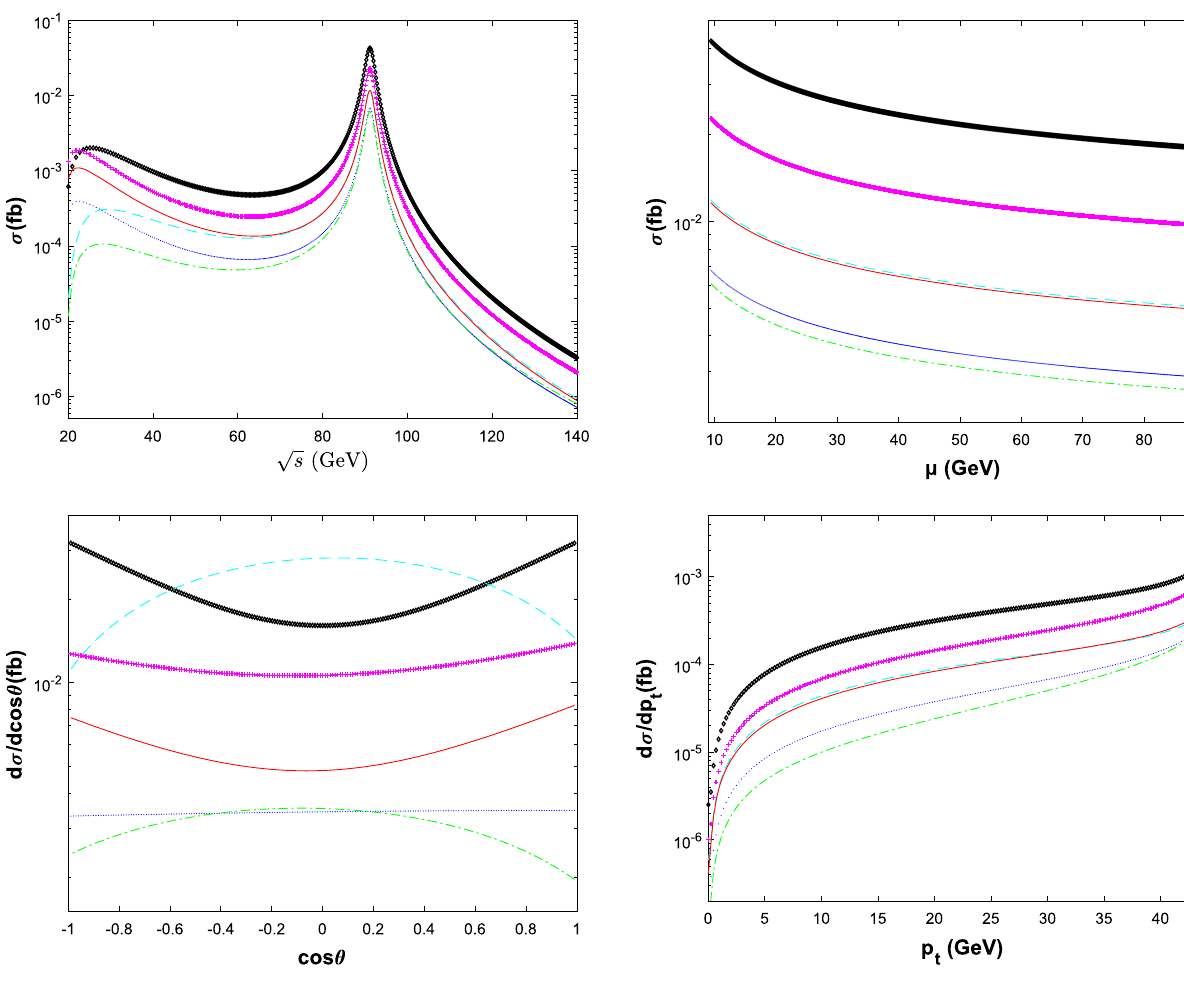
Fig. 3 Total cross sections versus the CM energy malization scale μ , the differential angle distributions d σ /dcos θ , and the p t distributions d σ /d p t at production. The diamond black line, cross magenta line, dashed cyan